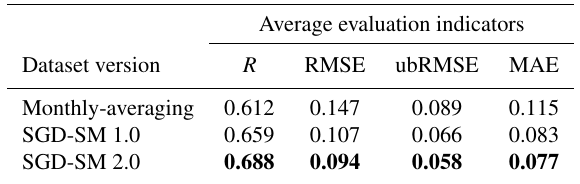
Table 4. Comparisons between the SGD-SM 1.0 and SGD-SM 2.0 products (from 2013 to 2019) through selected 124 in situ sites. The best indexes are marked as bold